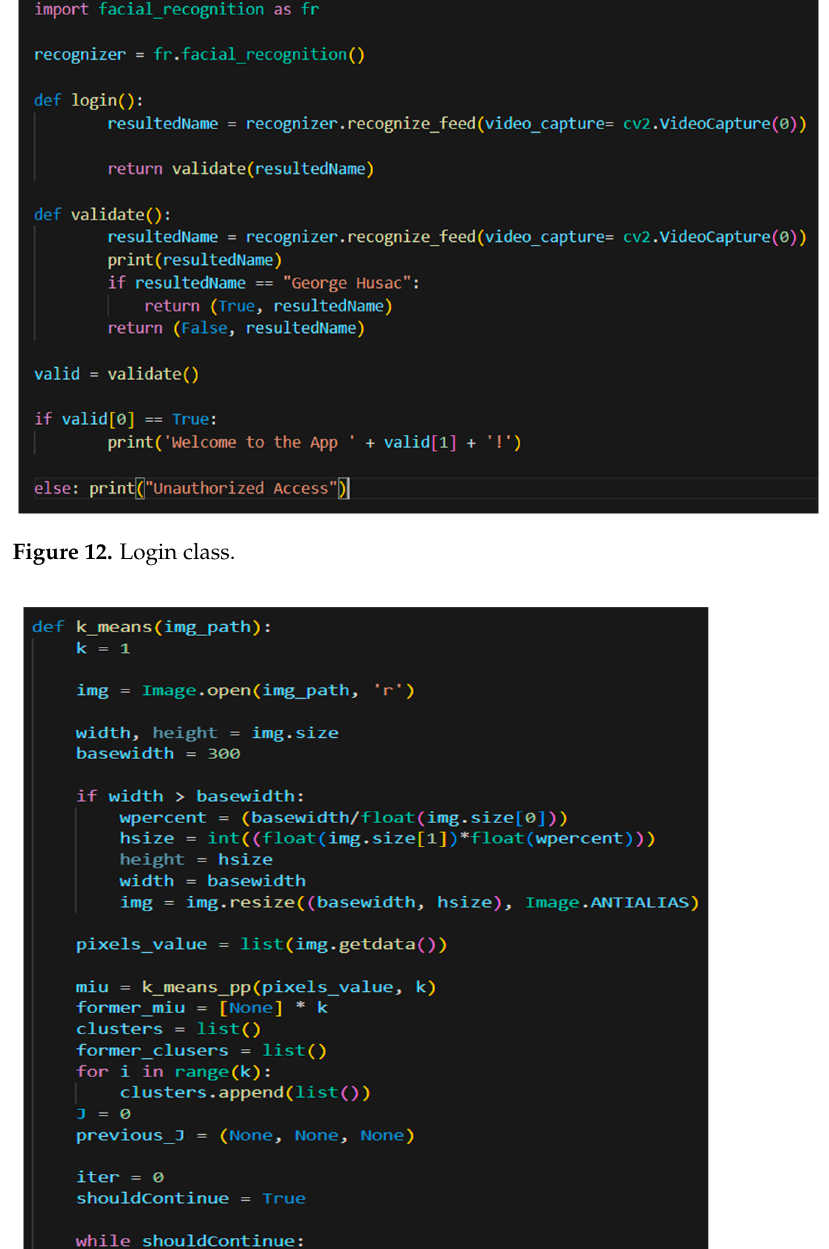
Figure 12. Login class.